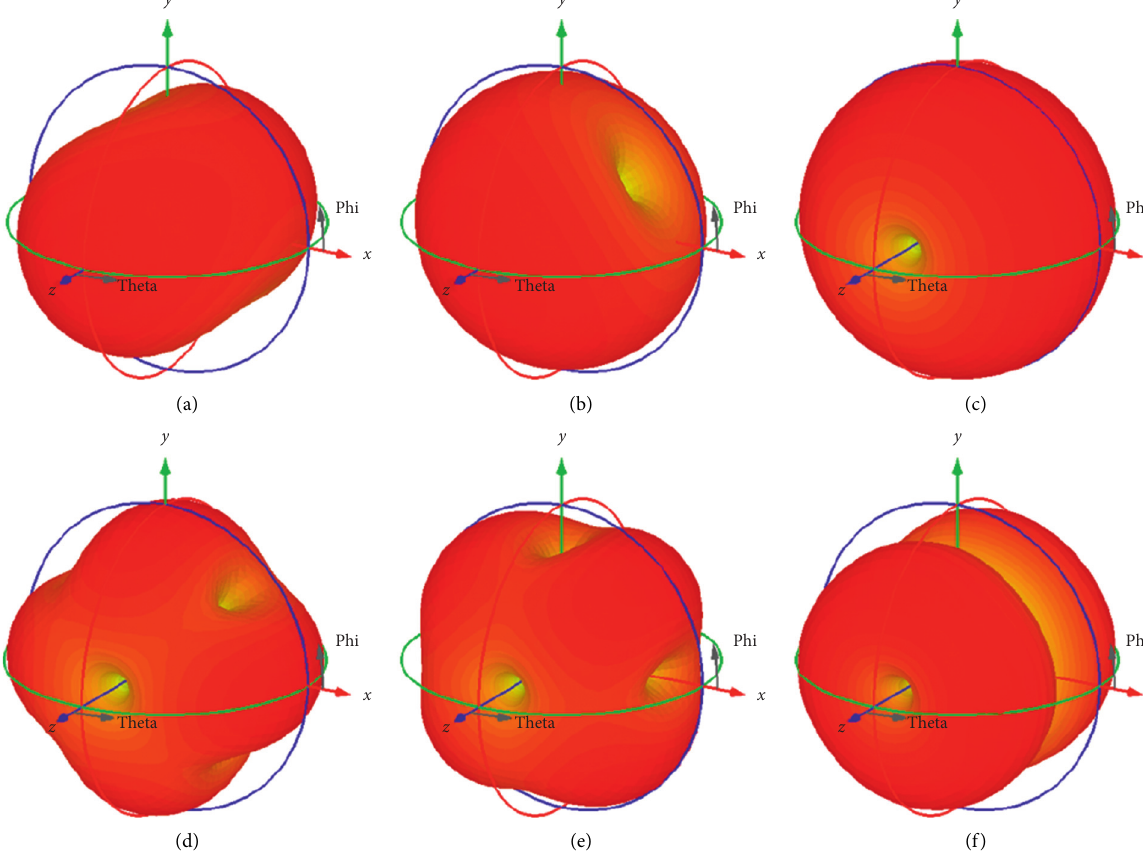
Figure 5: The simulated far-field patterns of J 1 J 6 at 922.5MHz of the CMA-based square loop radiator.